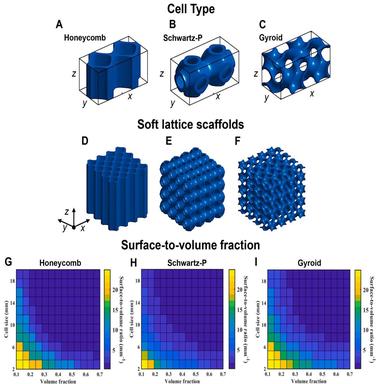
Unit cell geometry based on (A) honeycomb, (B) schwartz-P, (C) gyroid, and (D-F) corresponding cuboid matrix. (G-H) The surface-to-volume ratio for each tested cell obtained through FLatt Pack "surface-to-volume estimation" feature.